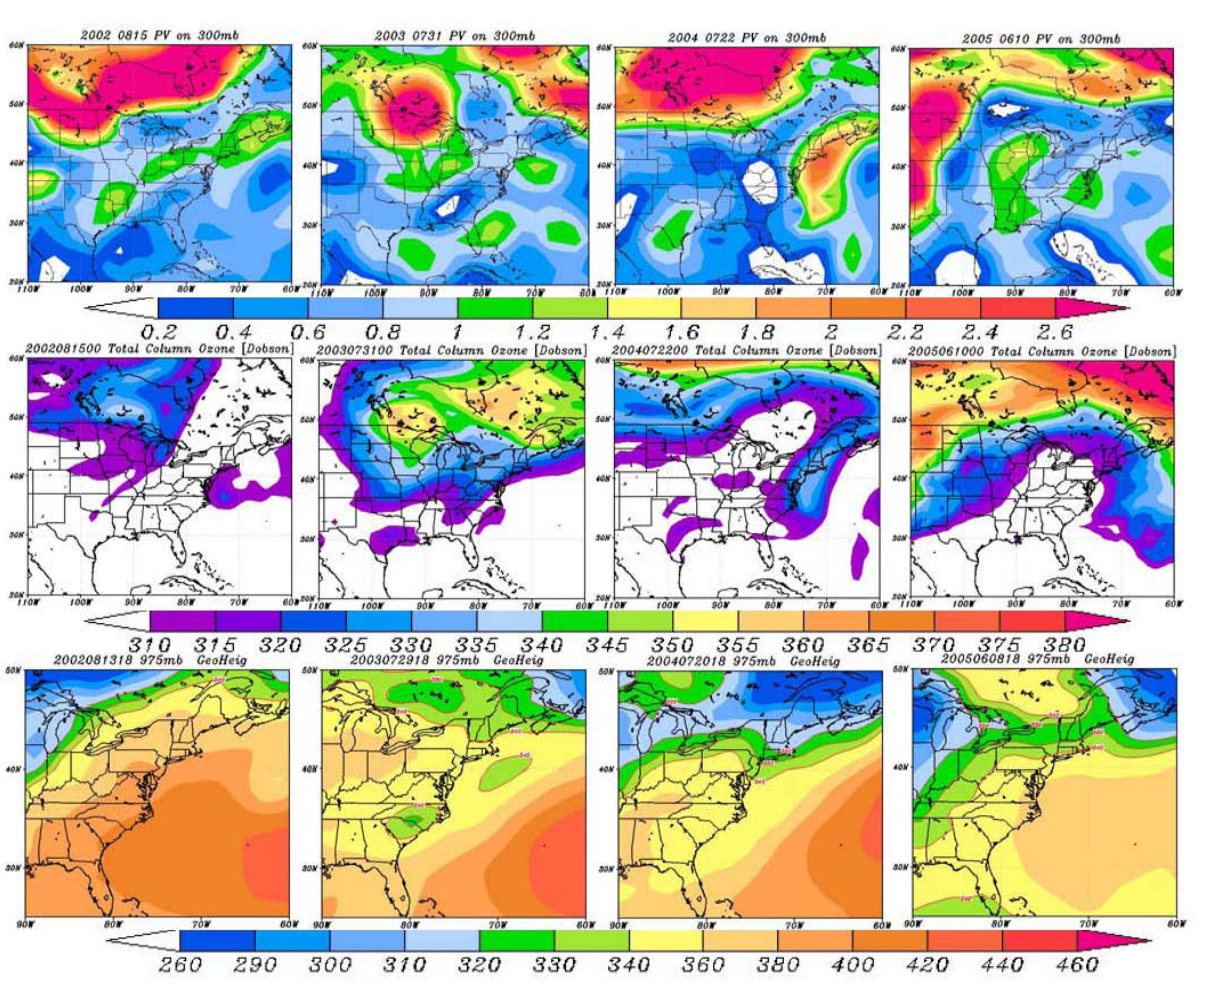
Figure 18. (Top panel) The NCEP 2.5° × 2.5° Potential Vorticity (PV) at 300 mb for the four highest events. Images from left to right represent years from 2002 to 2005. The shaded interval is 0.2 PV. (Middle panel) NCEP 1° × 1° total column O values are listed from 2002 (right) to 2005 (left). The interval is 5 Dobson Units. (Bottom panel) The NCEP 1° × 1° geopotential height at 975mb during the years of interest. A trough was present along the eastern coast in